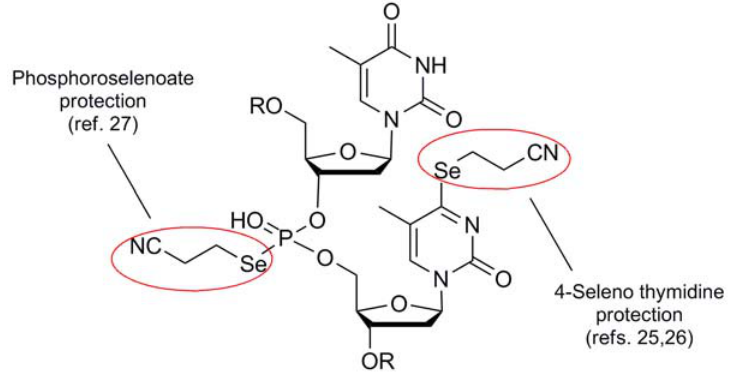
Figure 5. Use of 2-Cyanoethyl protection in the synthesis of Se-containing nucleotide